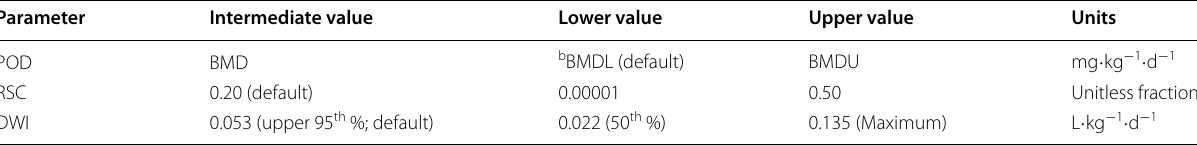
Table 1 Parameters a used in the sensitivity analysis of the derivation of the screening level